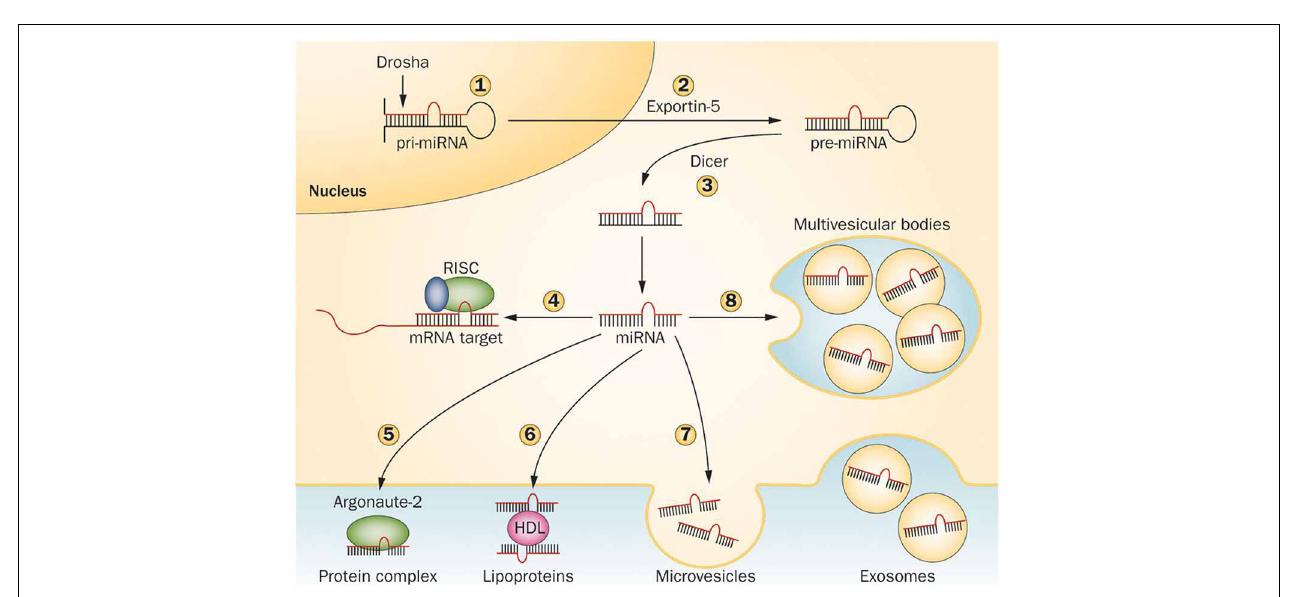
http://www.mirbase.org) is continuously growing, starting from few dozens in the first release (2002) to more than 2500 in the last release (version 20, June 2013).